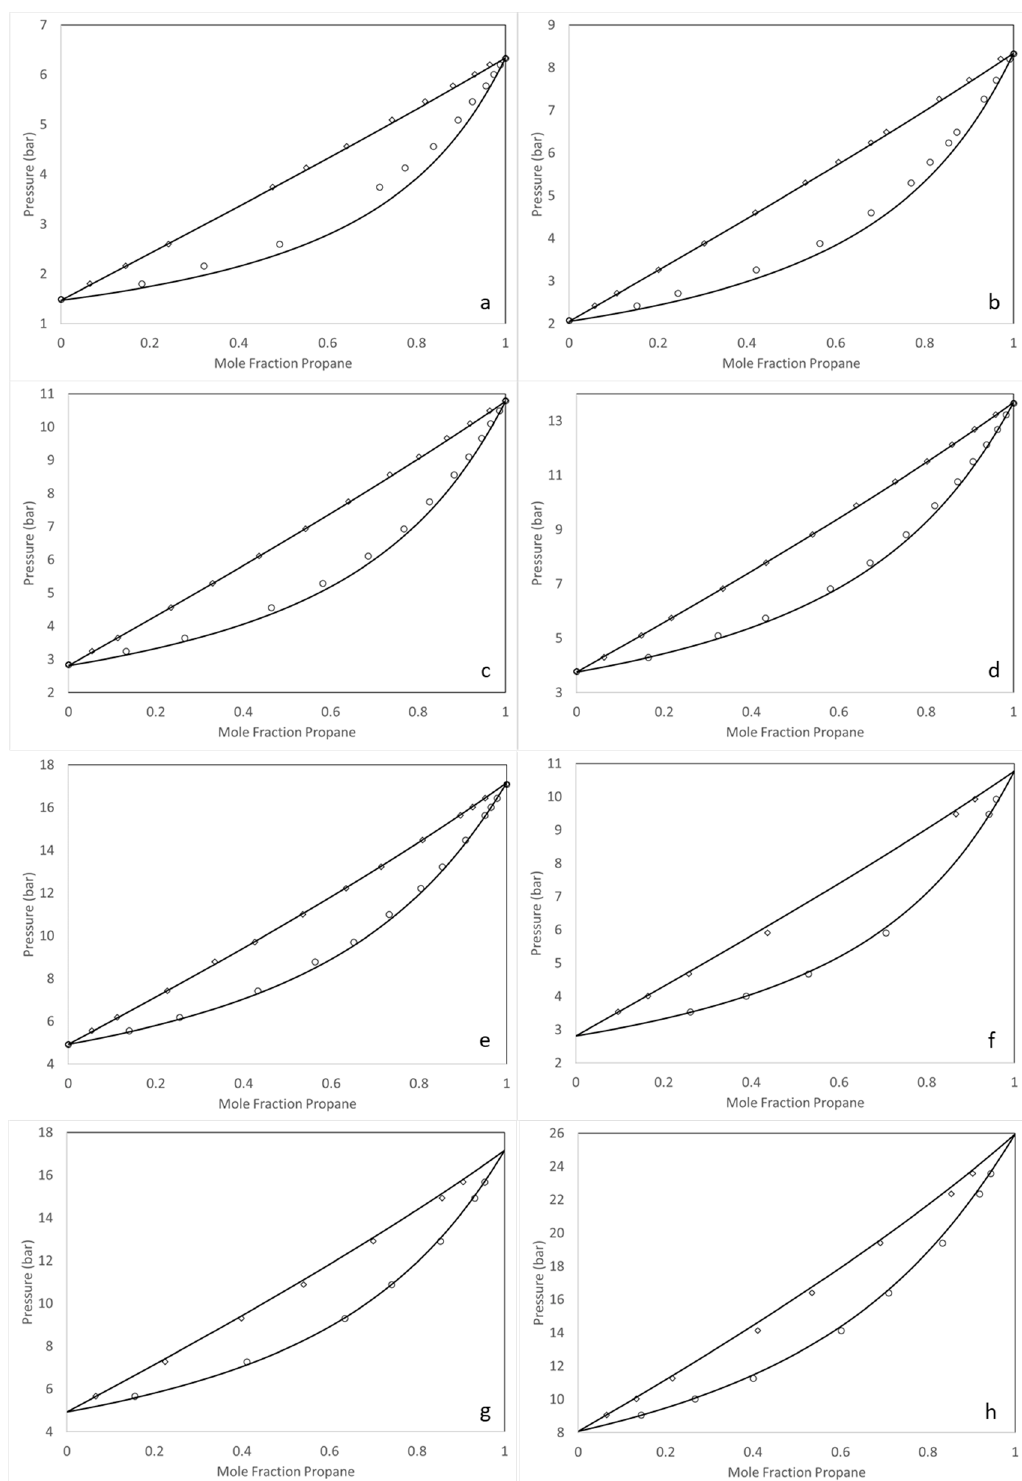
Figure 1. Vapor–liquid equilibrium data for the propane/butane mixture. Data were calculated using the Peng-Robinson EOS and the fugacity coefficient according to modified Raoult’s law. The symbols ♦ and o represent experimental data for liquid and vapor, respectively, and the line represents model predictions. ( a ) 283 K [32], ( b ) 293 K [32], ( c ) 303 K [32], ( d ) 313 K [32], ( e ) 323 K [32], ( f ) 303 K [33], ( g ) 323 K [33], ( h ) 343 K